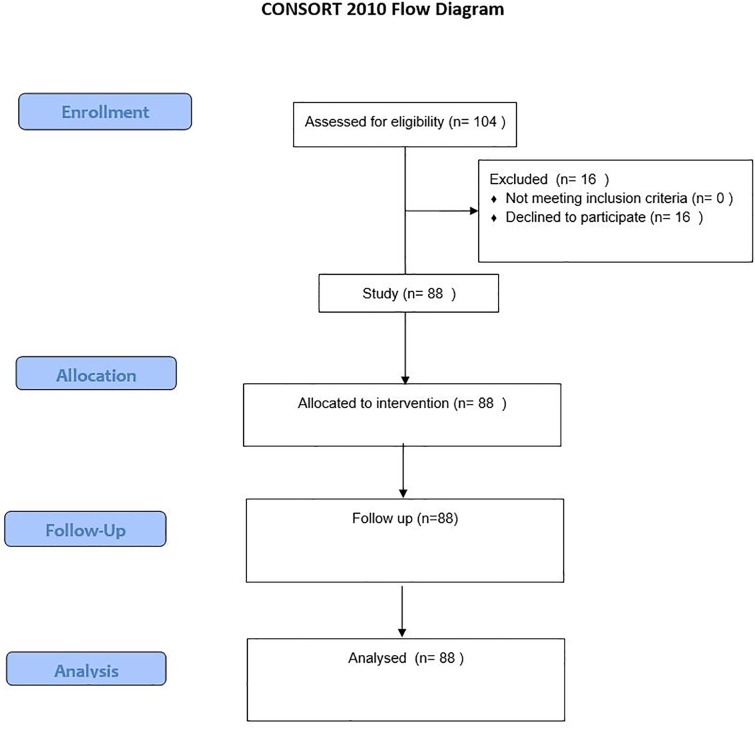
Consort diagram.